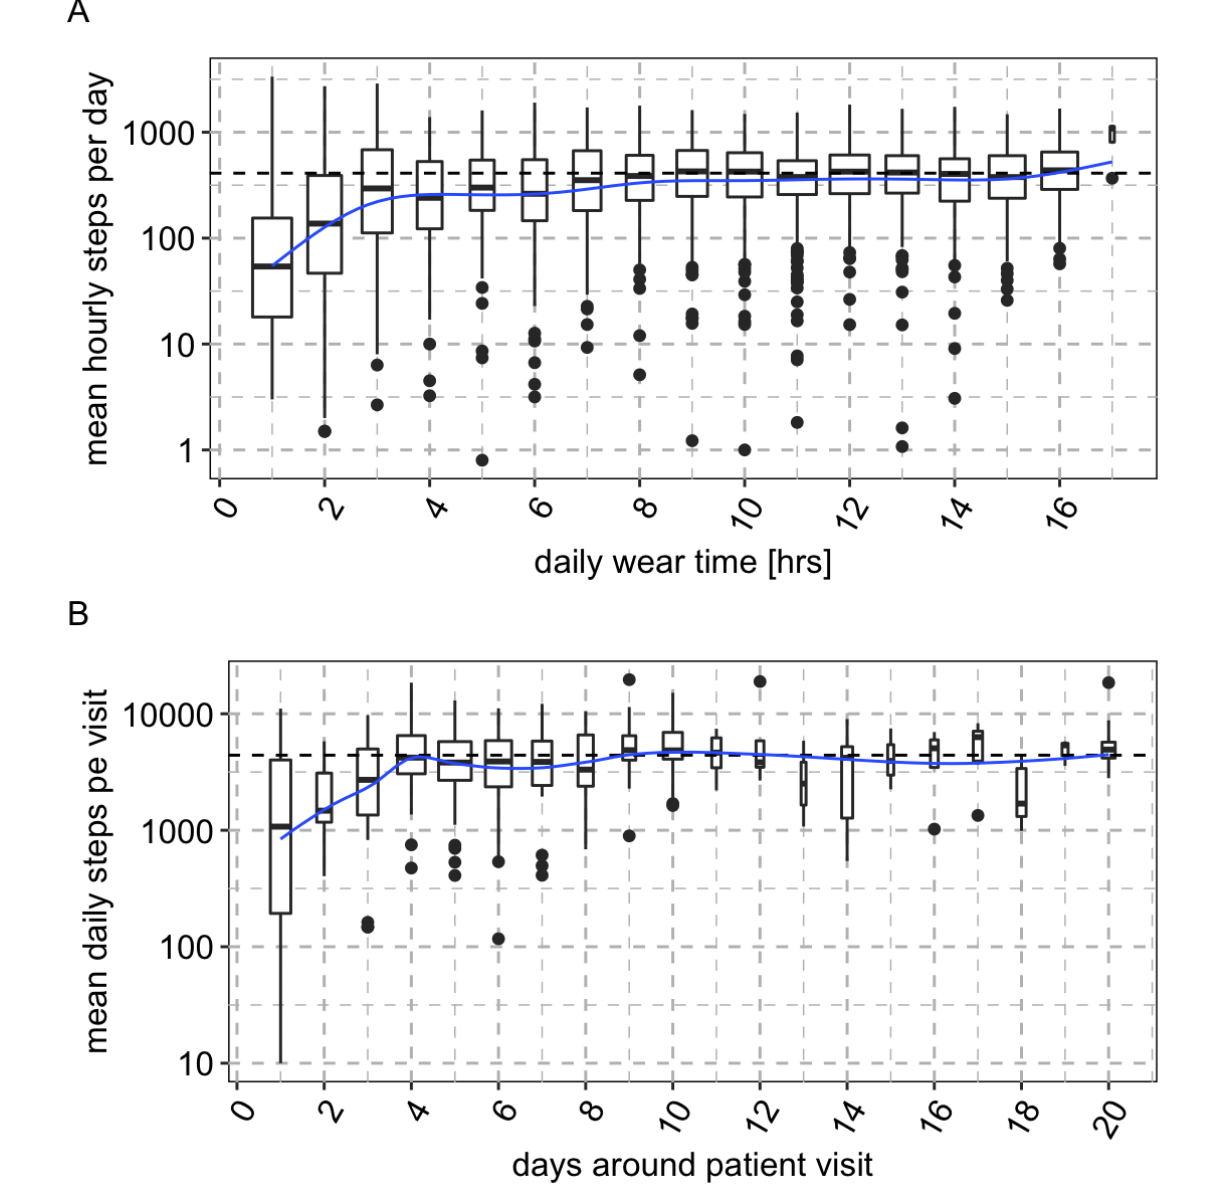
Figure 2. Effect of daily weartime and compliance around a visit on step count estimation. (A) The mean hourly steps per day is calculated for each day of patient observation as the total step count normalized to the detected weartime for that day. On the y-axis we show the distribution of mean hourly steps per day and patient, grouped by the total daily weartime in hours on the x-axis. The blue line is a smoothed Loess-fit. Mean daily steps are seen to drop sharply where less than 3 hours of weartime are detected. (B) After removing days of observation with less than 3 hours of weartime, we then calculated the distribution of average normalized daily step counts (“mean daily step count per visit”; total step count in a 20 day window straddling each planned visit divided by the number of compliant “days around patient visit” with a minimum 3 hours weartime). The “mean daily step count per visit” is plotted on the y-axis and the “days around patient visit” on the x-axis. The blue line is a smoothed Loess-fit. Mean daily steps per visit is observed to drop sharply where less than 3 compliant days are detected around a given visit. Combining the results of (A) and (B) we arrived at a two-component threshold of at least 3 days with at least 3 hours of compliance for robust capture of walking behavior in our